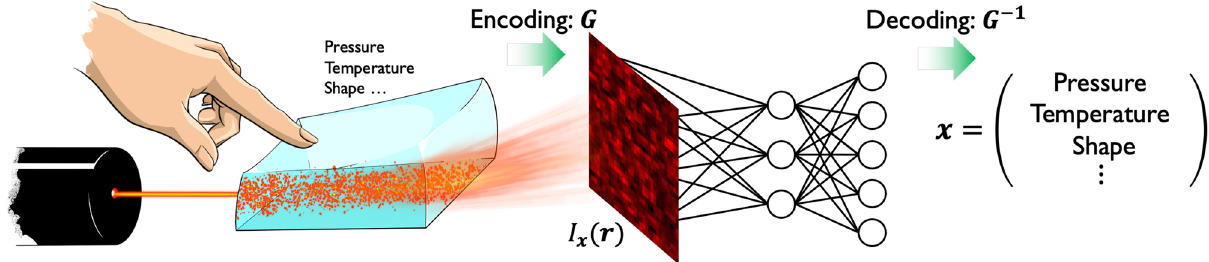
Figure 1. Conceptual schematic of the proposed soft sensing approach. The optical scattering phenomenon inside a soft material can induce a complex interference pattern, i.e., speckle pattern, which is highly sensitive to external stimuli on the material. The information on external stimuli, x , can be encoded as the speckle pattern, I x ( r ) . The proposed sensing approach is based on the speckle encoding and decoding using machine